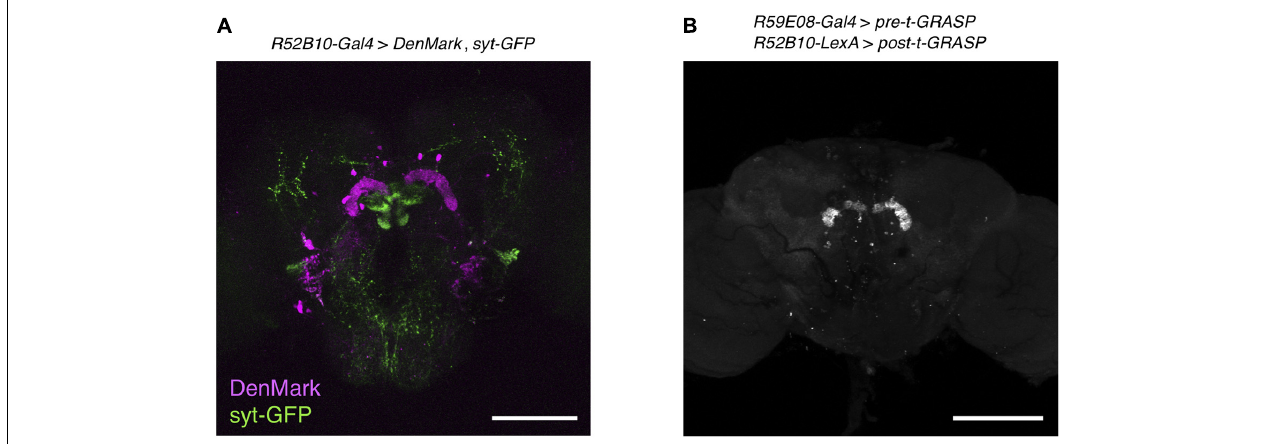
FIGURE 6 | The sleep-promoting PB interneurons form synaptic contacts with the wake-promoting PFN neurons. (A) The dendritic arbors and presynaptic terminals of the PFN neurons in R52B10-Gal4 were visualized by expression of the postsynaptic marker DenMark and the presynaptic marker syt-GFP, respectively. (B) The neuronal connection of the sleep-promoting PB interneurons to the wake-promoting PFN neurons was revealed using the t-GRASP method. The pre-t-GRASP and the post-t-GRASP encode the split-GFP fragments, which are targeted to presynaptic endings and dendritic terminals, respectively. Maximum-intensity projection of the confocal images of the brain expressing pre-t-GRASP with R59E08-Gal4 and post-t-GRASP with R52B10-LexA . Scale bars represent 100 µ m.